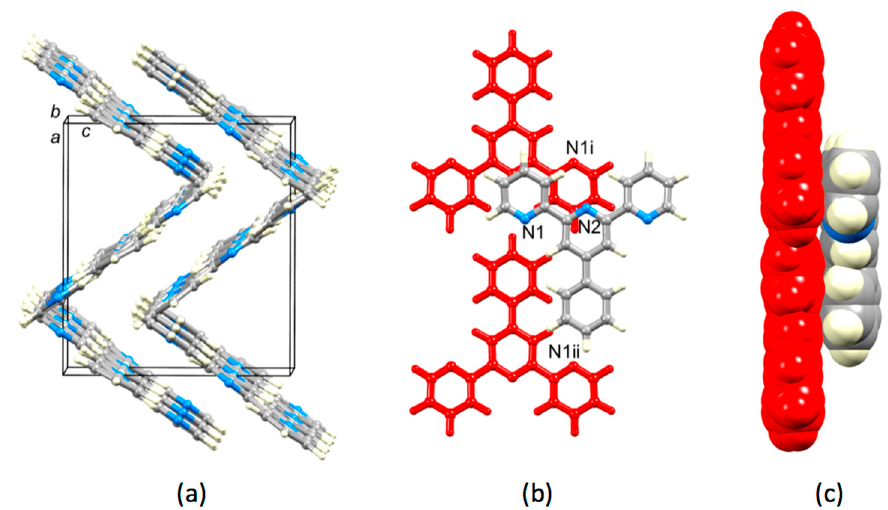
Figure 9. Packing of molecules in the crystal lattice of 1 (refcode SIXLAM [24,41]). ( a ) Molecules assemble into ribbons, which then stack in a herringbone manner. ( b ) Arrangement of molecules in adjacent ribbons; molecules colored red are in one ribbon, and the third molecule is in an adjacent ribbon. Symmetry code i = − x , − y , 1 − z . ( c ) Side view and space-filling representation of the three molecules are shown in ( b ).